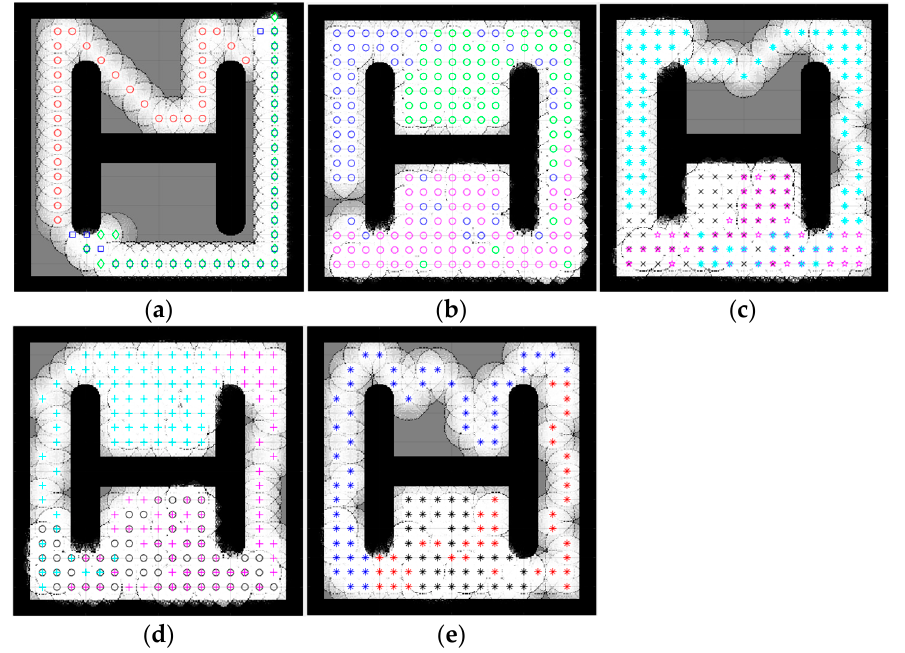
Figure 8. Percentage of the explored area after implementing the CME-SSA and the other approaches on complex map 2. Complex map 2: ( a ) CME 52.16% (Iteration 33); ( b ) CME-SSA, 96.45%; ( c ) CME-GWO, 80.61%; ( d ) CME-GWOSSA, 89.13%; ( e ) CME-SCA, 76.57%.